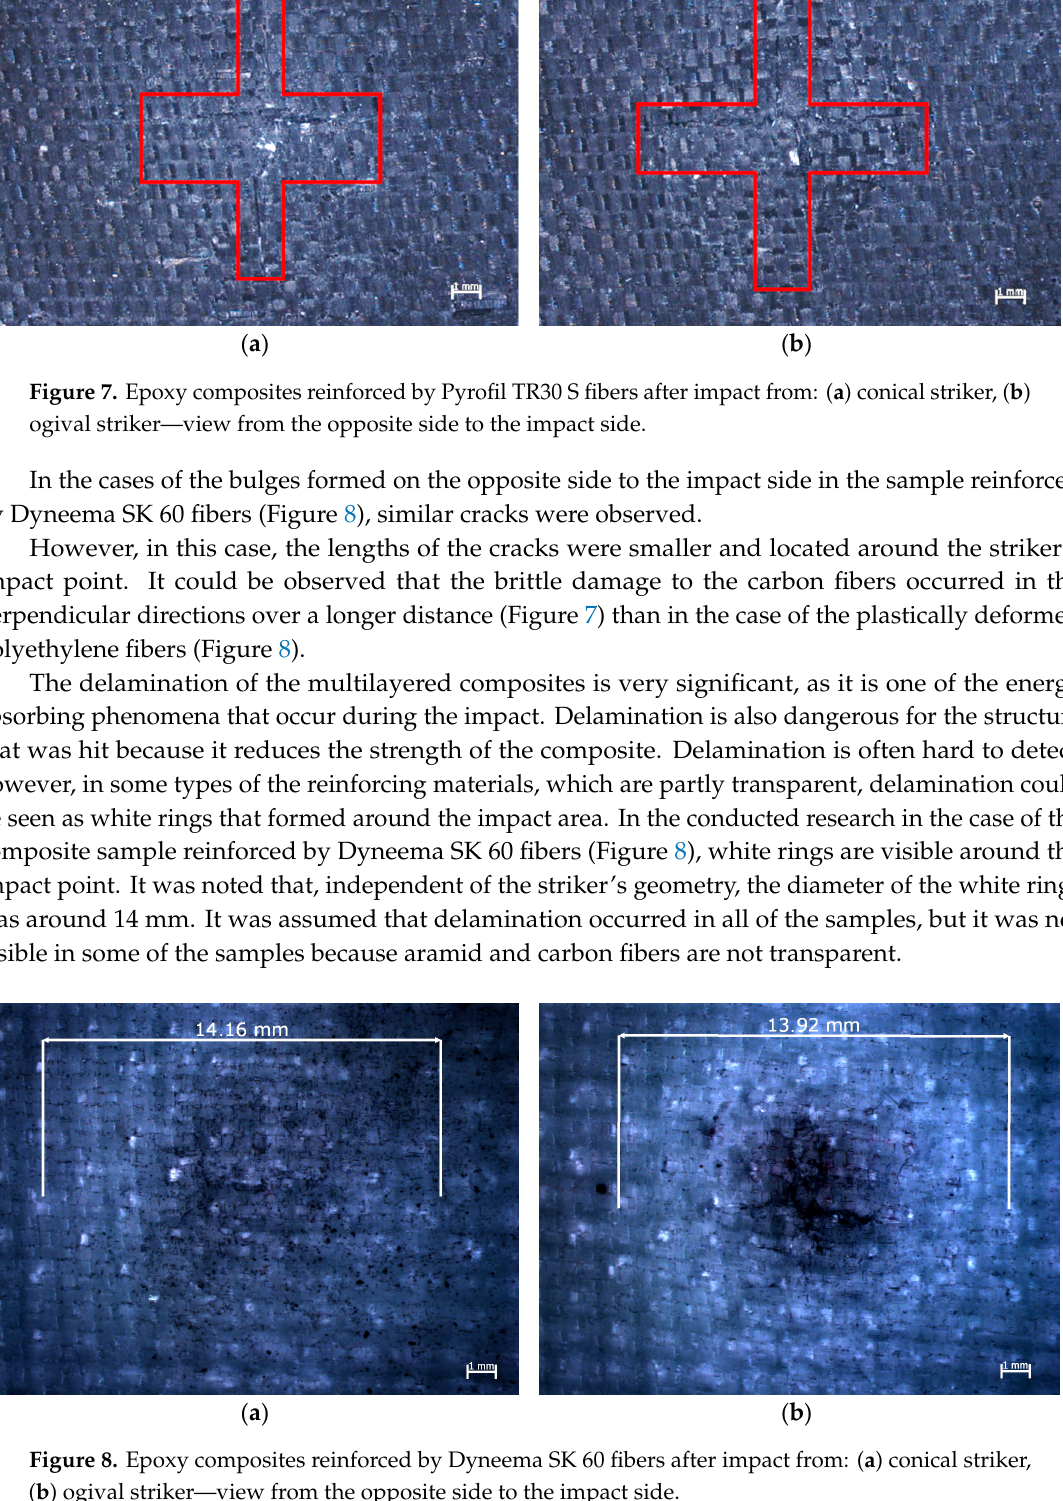
Figure 8. Epoxy composites reinforced by Dyneema SK 60 fibers after impact from: ( a ) conical striker, ( b ) ogival striker—view from the opposite side to the impact side.